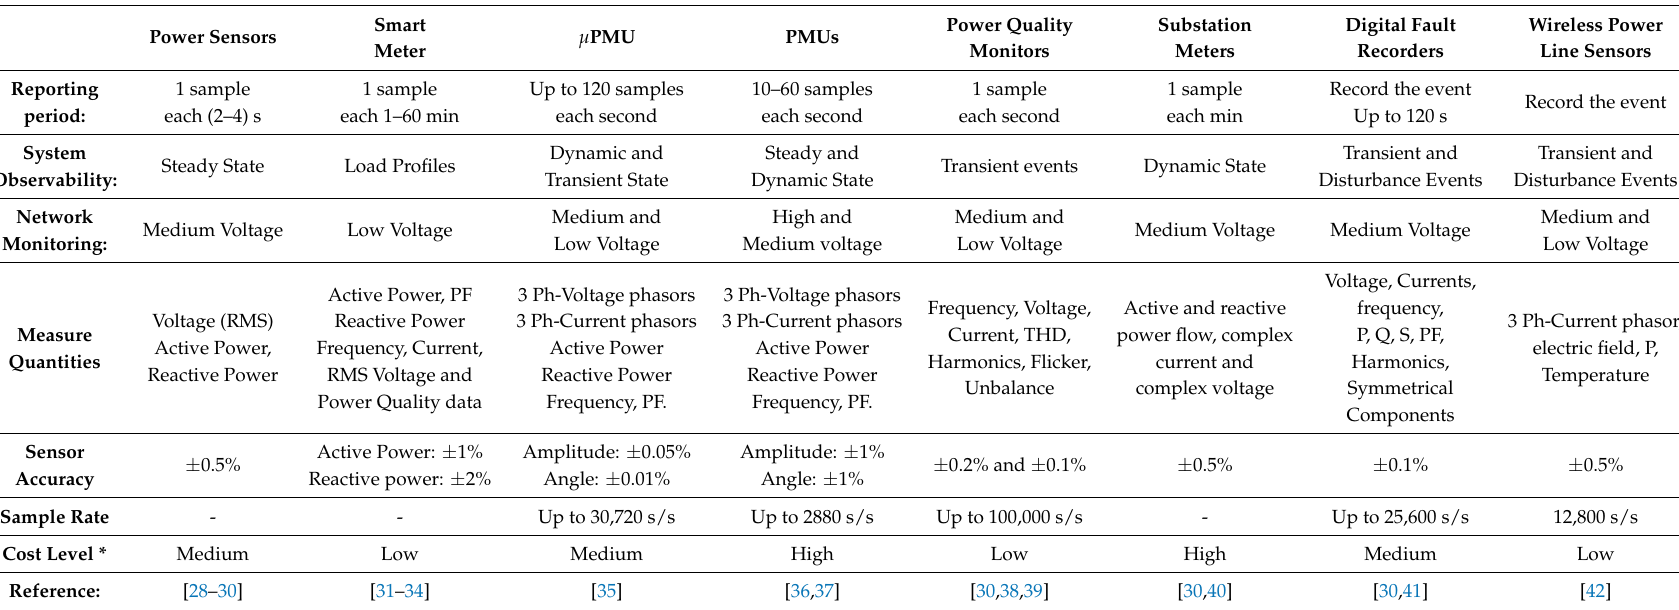
Table 1. Comparison table of advanced measurement devices in distribution